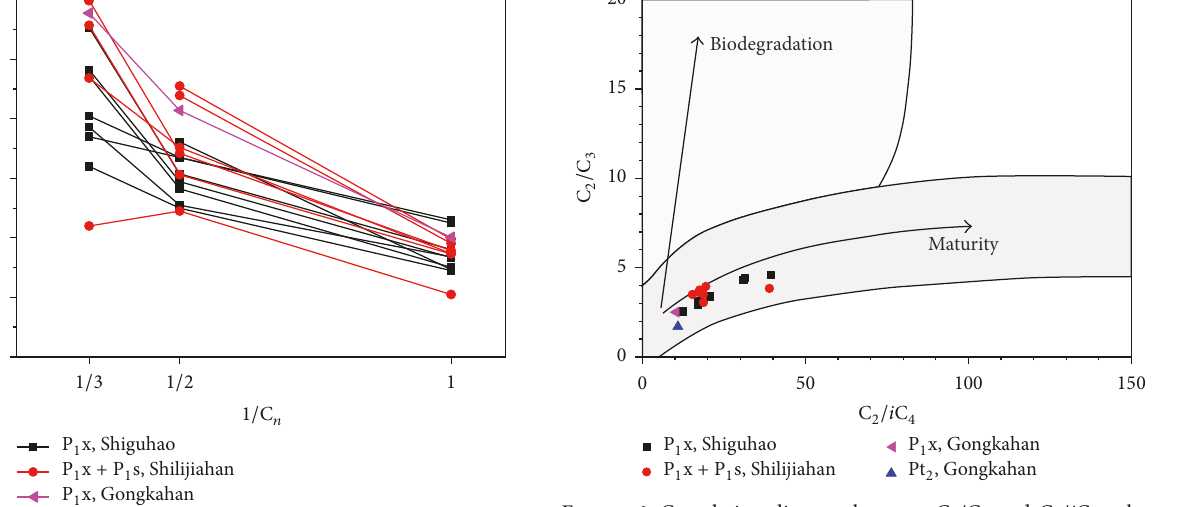
Figure 5: Hydrogen isotopic series of alkane gas from the Hangjinqi area in the Ordos Basin.